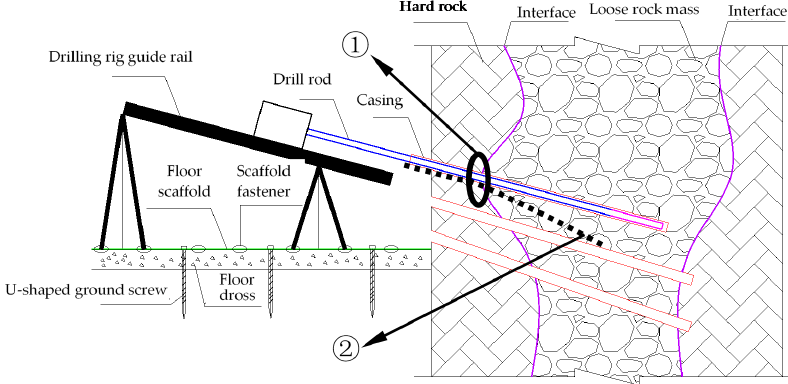
Figure 3. Technical difficulties in the process of drilling with casing in the composite rock mass.